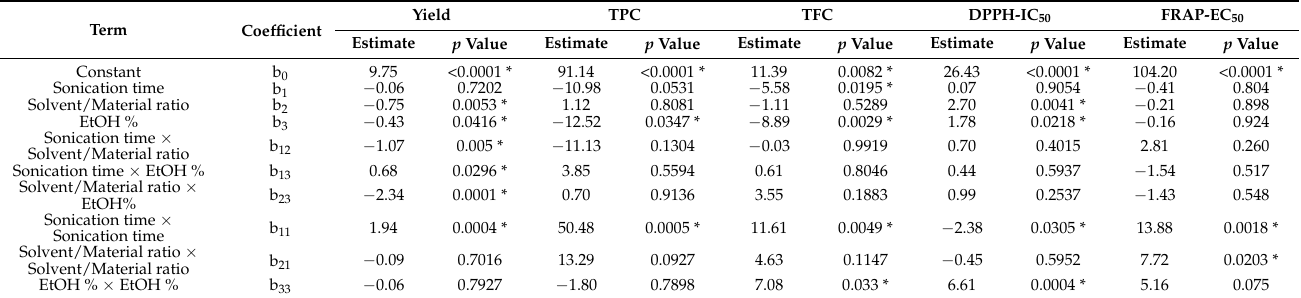
Table 4. Estimated regression coefficients of the special cubic